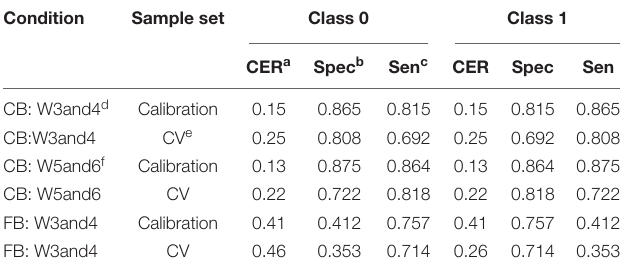
TABLE 2 | The classification error rate, specificity, and sensitivity of the partial least squares discriminant analysis (PLS-DA) models constructed for chocolate browning (CB) and friction browning (FB) of ‘Regal Seedless’ grape